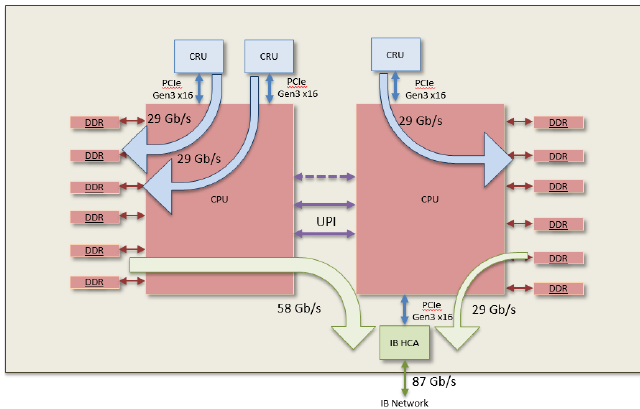
Figure 3. DMA and RDMA data flow, crossing two CPUs and di ff erent memory banks. The data is sent out to the network using an IB HCA (InfiniBand Host Channel Adapter) card